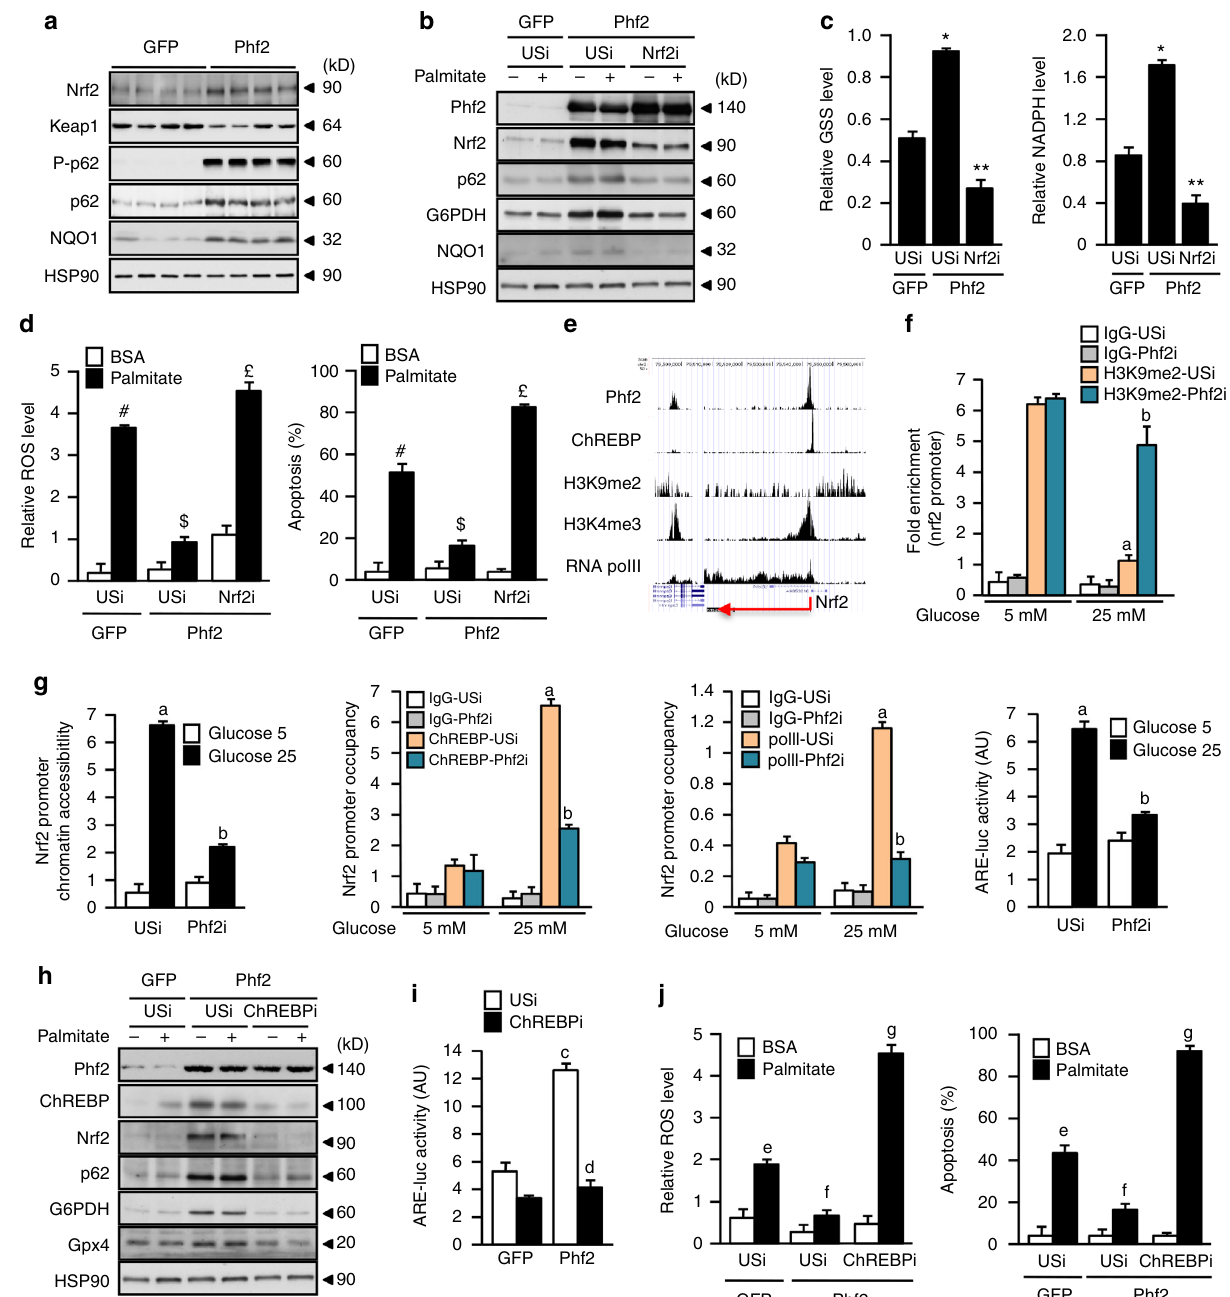
Fig. 5 Phf2 and ChREBP decrease oxidative stress through Nrf2 activation. Mice, injected with either GFP or Phf2 overexpressing adenovirus, were